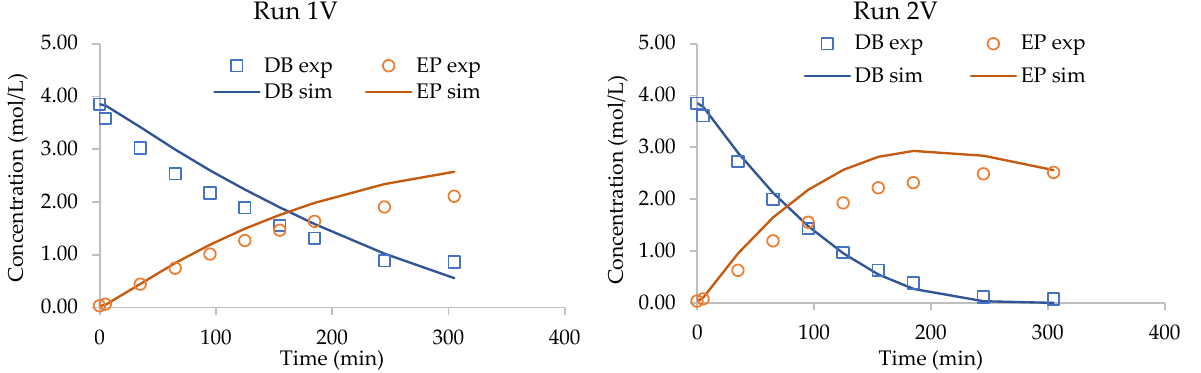
Figure 15. The fit of the model to Runs 1V and 2V for the validation stage. (DB: double bond and EP: epoxide).